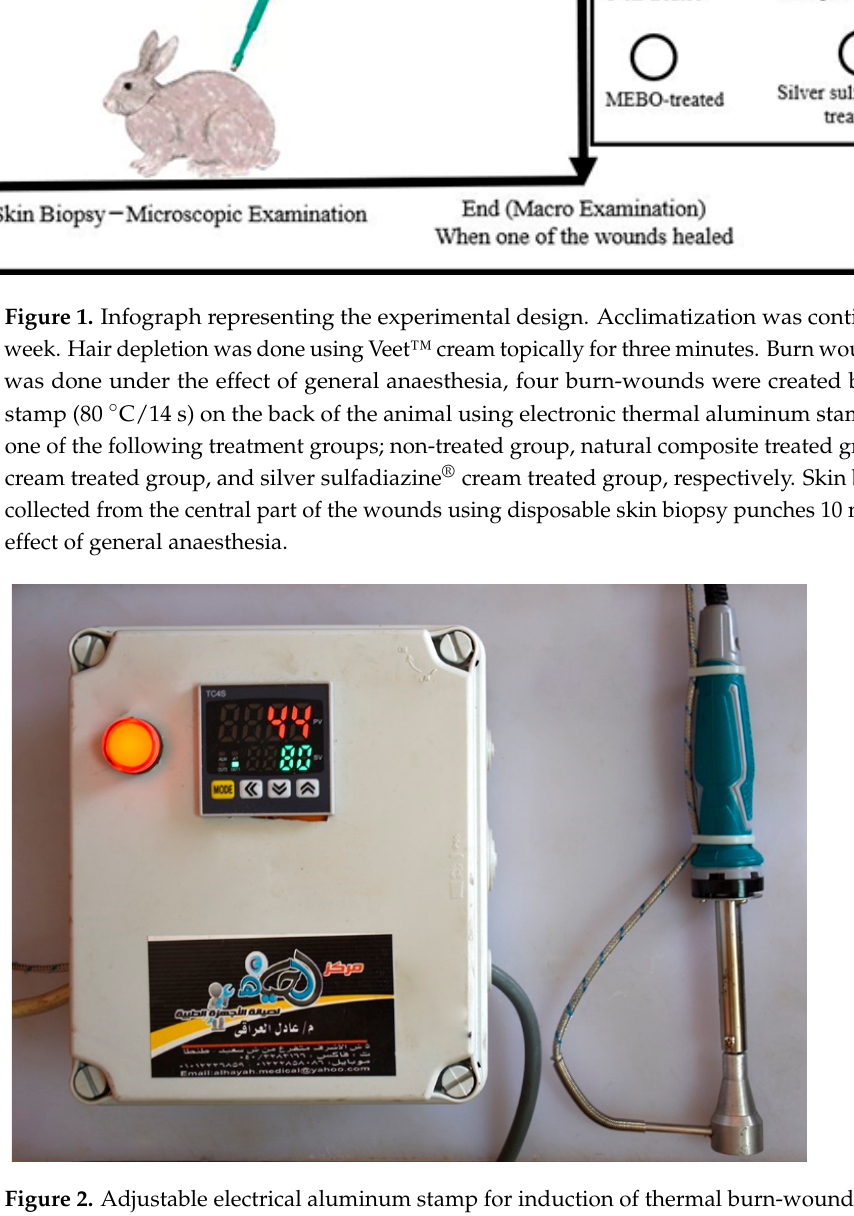
Figure 3. Induction of skin burns in adult New Zealand rabbit. Skin burns were induced using alu ‐ minum stamp; the contact area was 4 cm 2 . The site of wounds was anatomically fixed in all rabbits and the distance between the two wounds in the same side was 11 cm, while the distance between wounds from right to left sides was 7 cm. At the first day of burn induction, skin biopsies were taken from one rabbit at the center of the wound, by using disposable skin biopsy punches 10 mm (MentoK, Jaipur, India), under the effect of general anesthesia for histopathological evaluation of the wounds directly after burn induction. The other nine rabbits were used for the experiment. Treatments were applied once a day topically on the wound and the non ‐ treated group received nothing. The experiment was terminated when one of the wounds appeared to